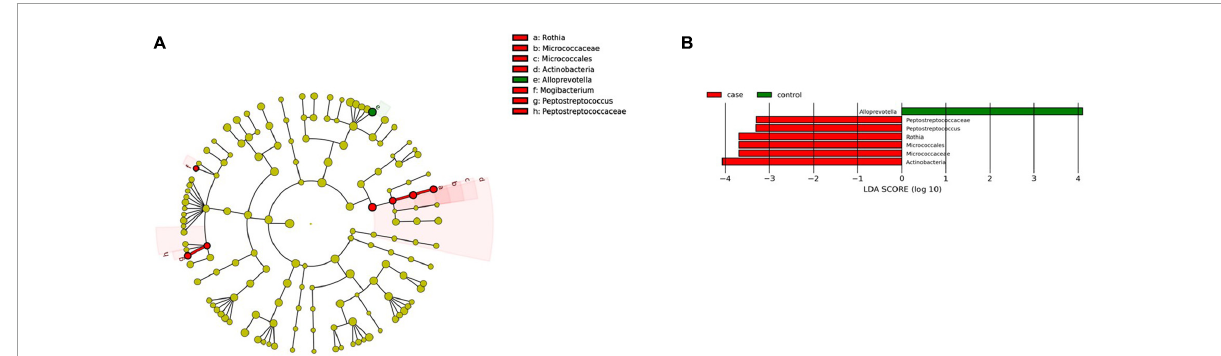
FIGURE7 Linear discriminant analysis (LDA) integrated with effect size (LEfSe). (A) Cladogram representing the differentially abundant taxonomic groups in the microbiota from the pharynx of patients with CeD. (B) Graph bar representing the microbial biomarkers found in the microbiota from the pharynx of patients with CeD (LDA score > 3, p < 0.001). Control: Control group, represented in green. Case: Patients with CeD, represented in red.